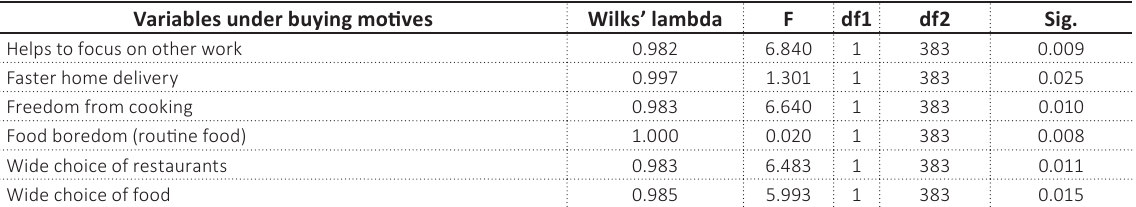
Table 4. Discriminant analysis of variables under buying motives